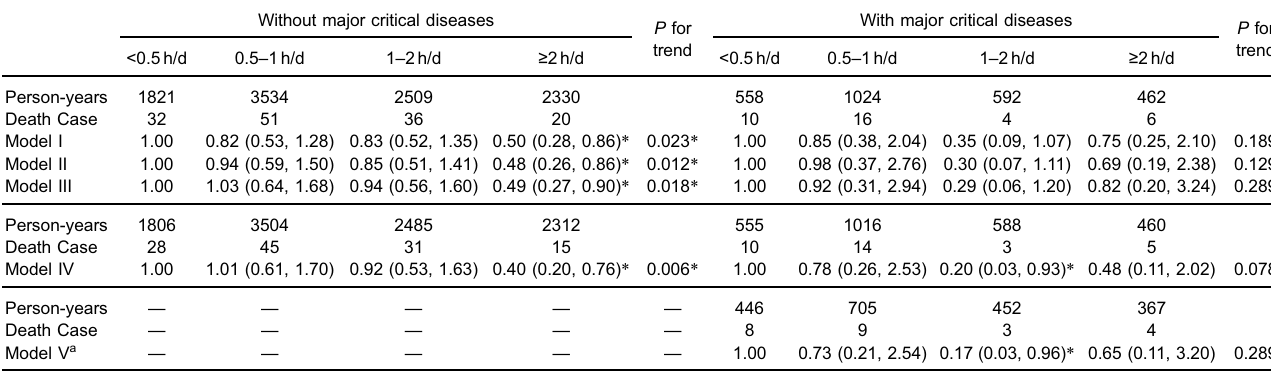
Table 3. Association of daily walking with mortality according to morbidity of major critical diseases